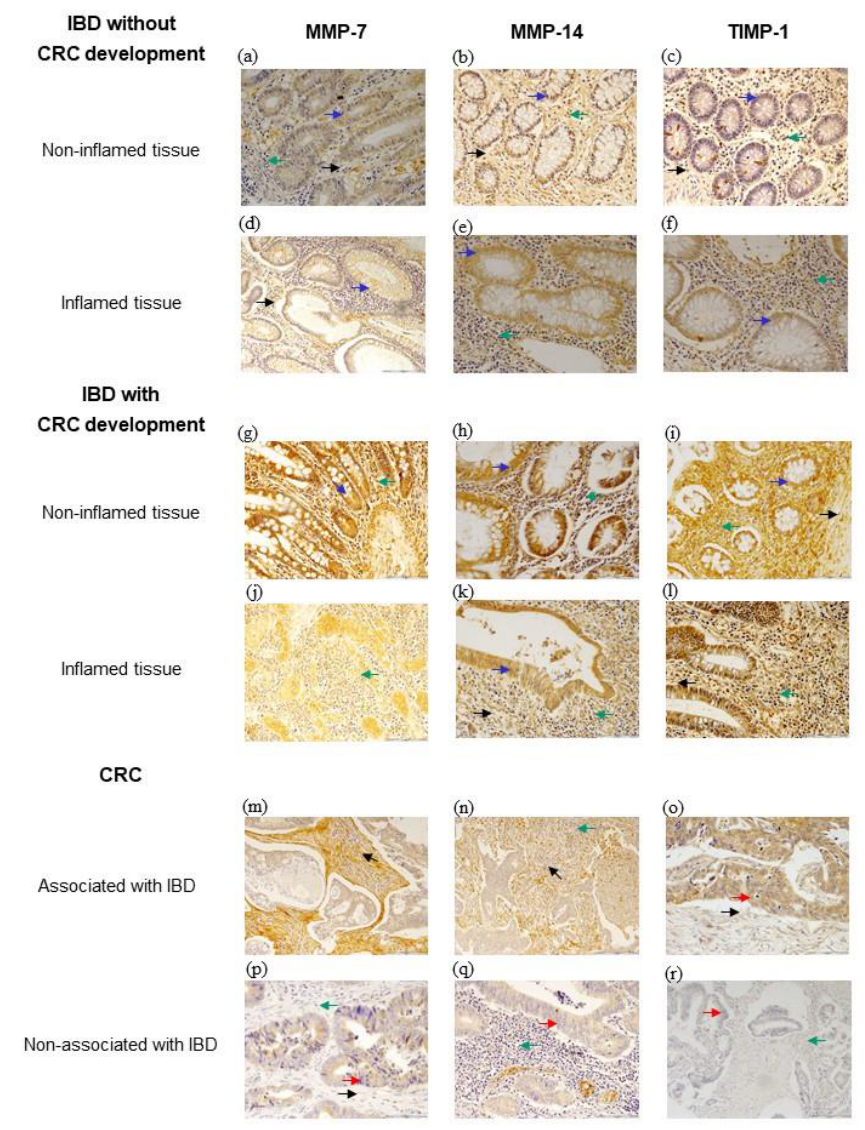
Figure 1. Representative examples of immunohistochemical staining for MMP-7, MMP-14 and TIMP-1 in colonic mucosa of patients depending on the group of study. 100× magnification for ( a – c , g – l , p – r ). 200× magnification for ( d – f , m – o ). The counterstaining was made with hematoxylin. Arrows indicate cell types: red, cancer cells; blue, epithelial cells; green, mononuclear inflammatory cells; and black, fibroblasts. CRC, colorectal cancer; IBD, inflammatory bowel disease. Note: Samples on tissue sections were either insufficient or lost for analysis in 10 cases for MMP-7 in CRCs not associated with IBD; in 5 cases for MMP-14 in CRCs not associated with IBD and in 8 cases of CRCs associated with IBD; in 13 cases for TIMP-1 in CRCs not associated with IBD and in 8 cases of CRCs associated with